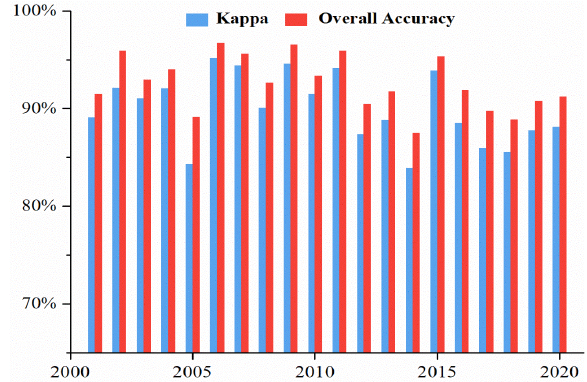
Figure A1. Annual land use classification accuracy.